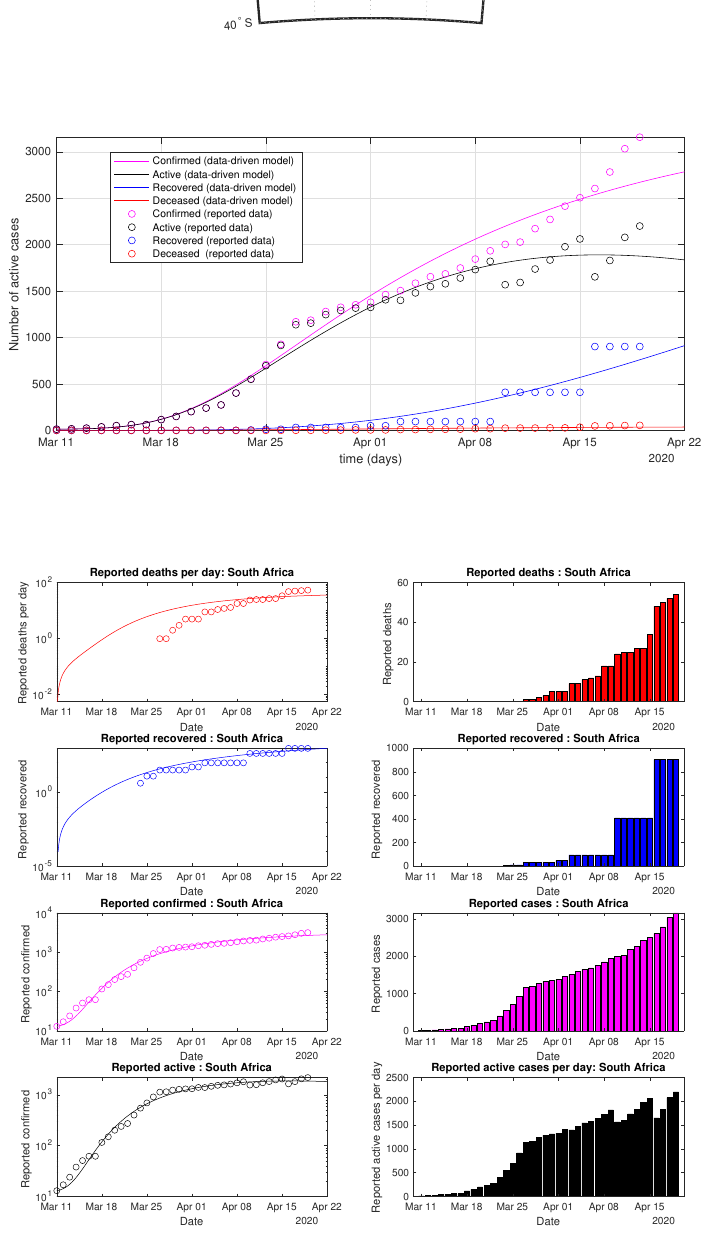
Figure 84. SouthAfrica: data vs.